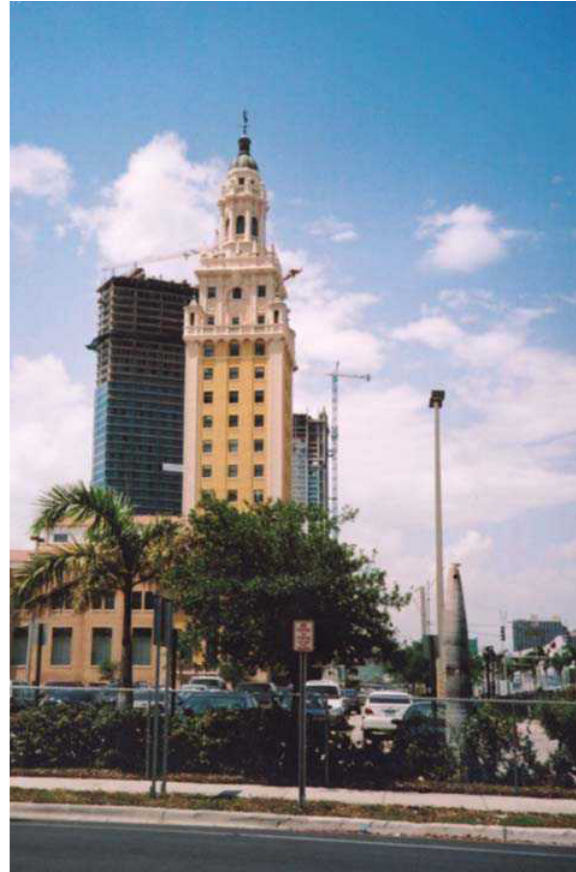
Fig 2. Respect of Freedom Palace in Florida. Formation of exposition-